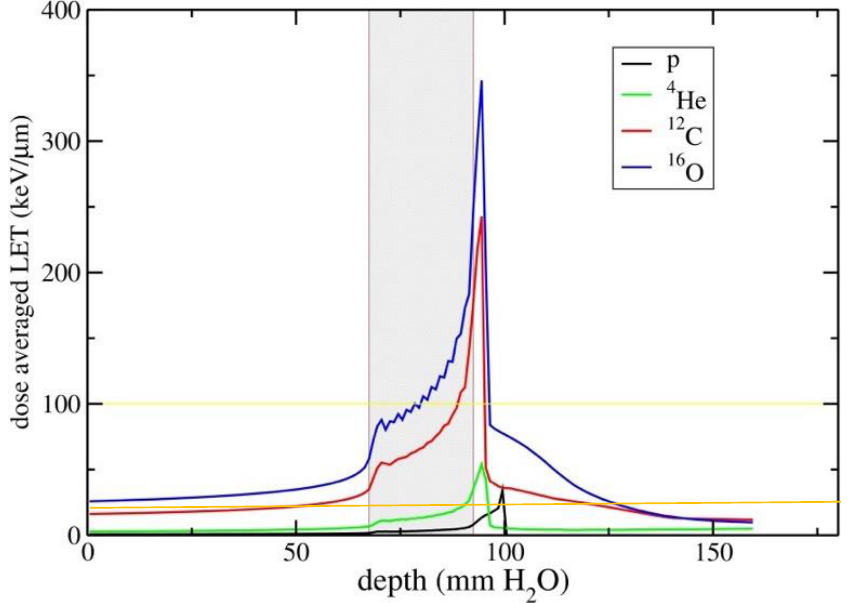
Figure 3. LET versus depth in tissue for a single SOBP of p, He, C, and O providing a uniform physical dose (2 Gy). The grey area represents the tumor region, a 2.5 × 2.5 × 2.5 cm 3 volume centered at 8 cm in water. The yellow and orange lines are 100 and 20 keV / µ m level, respectively. Figure from [15], distributed under Creative Commons